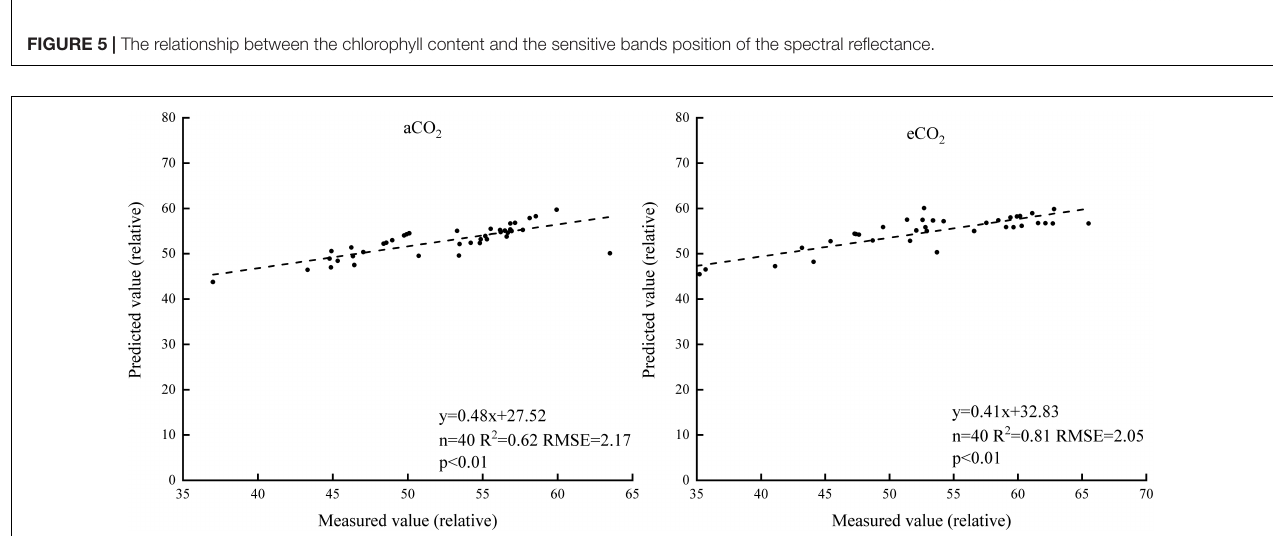
FIGURE 6 | The measured and estimated values of chlorophyll content based on the sensitive band position model under aCO 2 and eCO 2 .